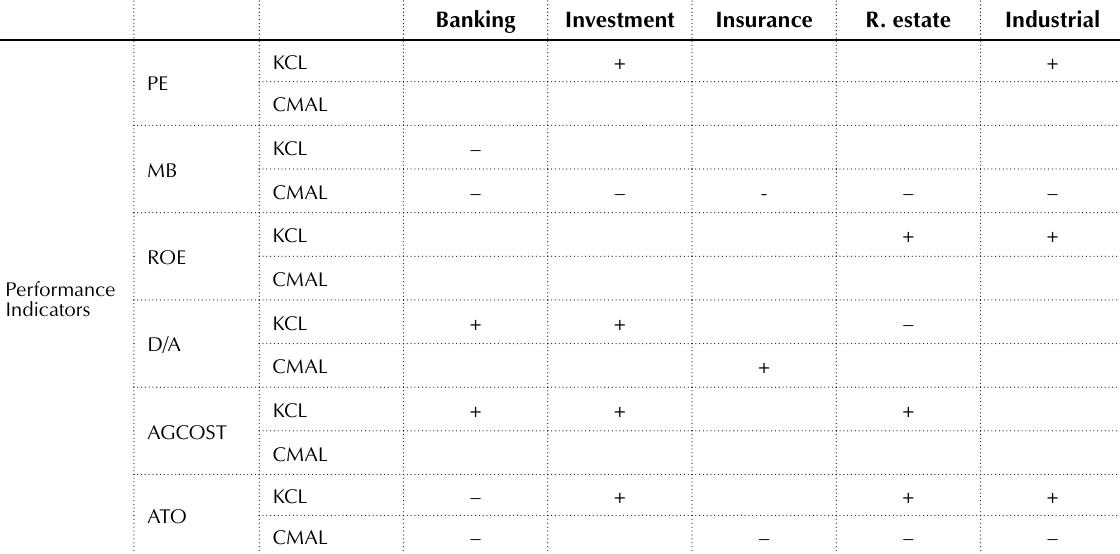
Table 12. A summary of the resulting signs of all significant